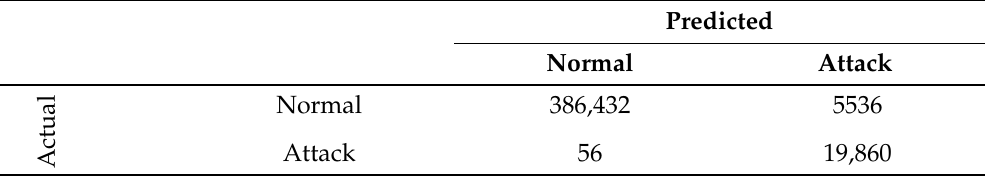
Table 16. Confusion matrix for UNSW-NB15 “class weights” binary classification